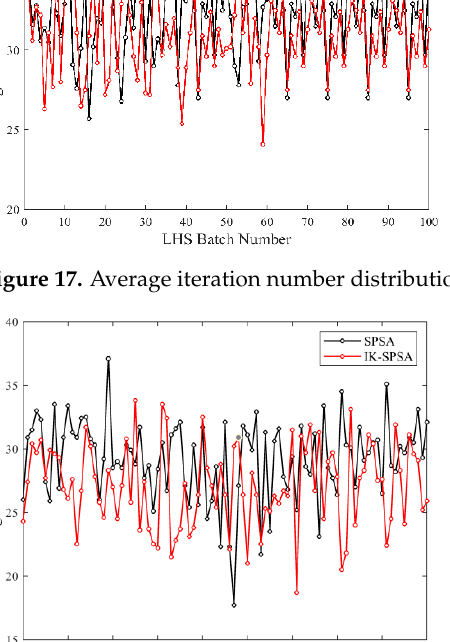
Figure 18. Average iteration number distribution at different initial points.